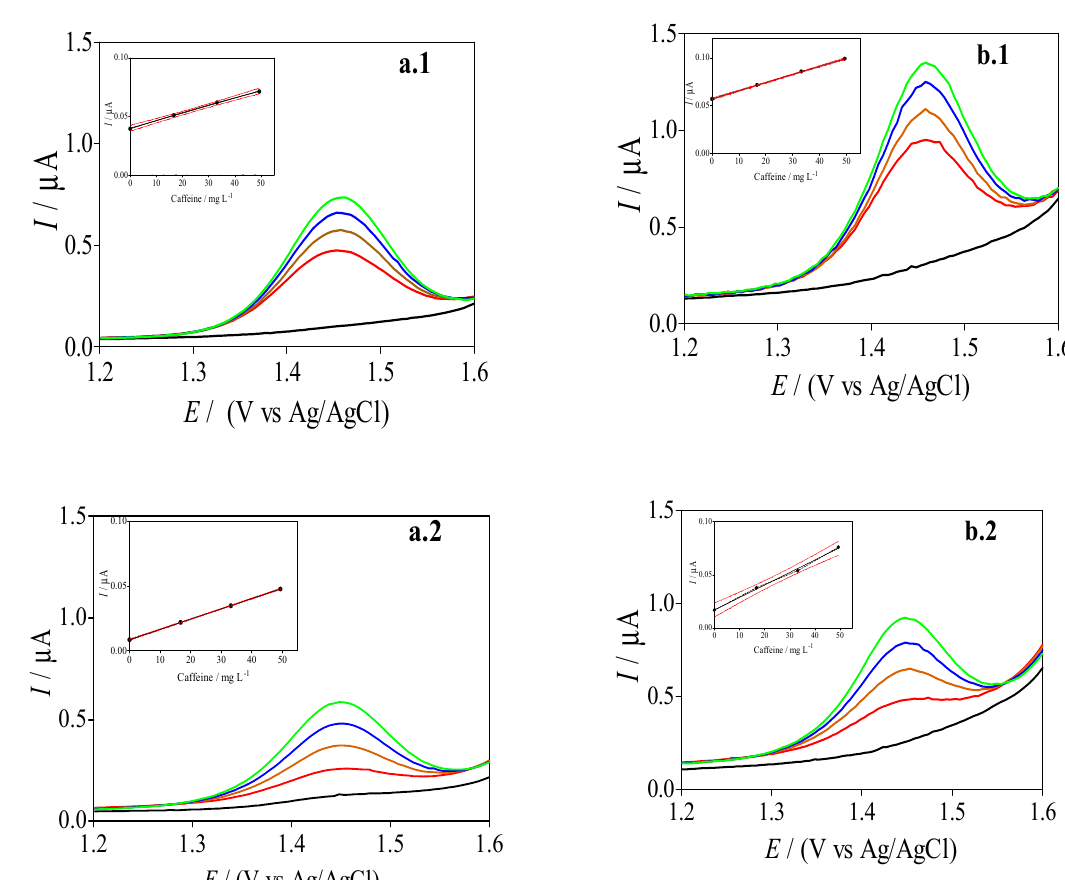
Figure 7. Determination of caffeine in real samples by using ( a ) GrRAC and ( b ) GrRGC electrochemical sensors: (1) drug and (2) beverages. Standard additions of 0.01 M caffeine in 0.5 M H 2 SO 4 : (-) supporting electrolyte, (-) sample, (-) 200, (-) 400 and (-) 600 µL. Inset: calibration plots of caffeine concentration in solution versus peak current.